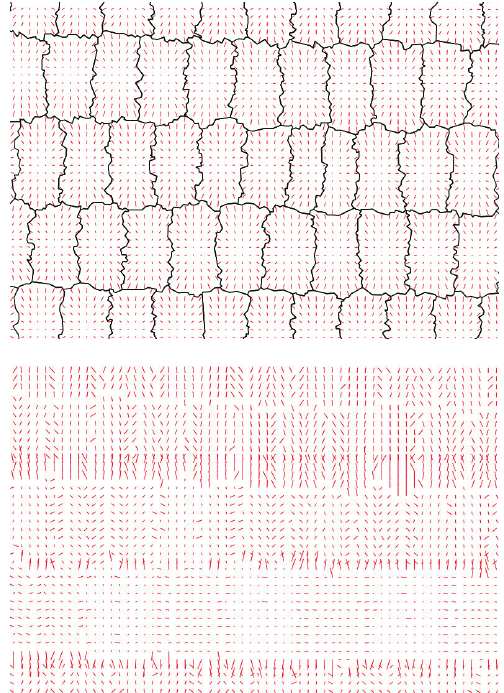
Figure 9. D / H lever effect for a second orthomosaic covering the same area as in Figure 4 (above) and differences between the D / H lever